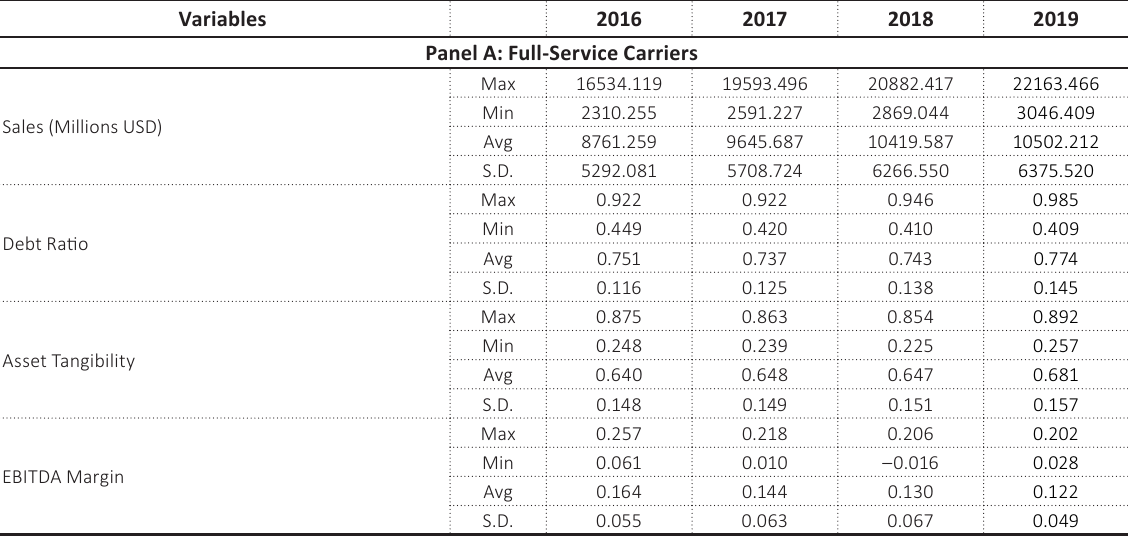
Sources: S&P NetAdvantage and airline